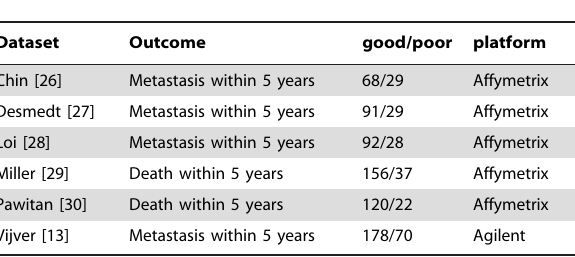
Table 2. Microarray expression